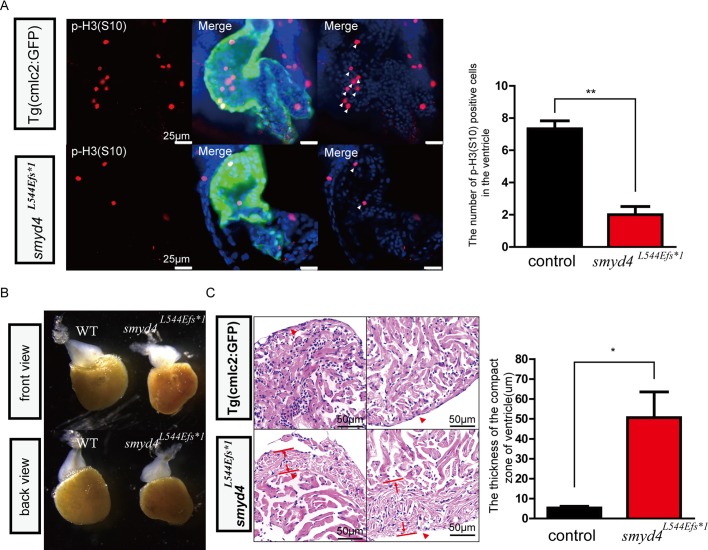
Phenotypical analyses of MZsmyd4L544Efs*1 embryos.(A) The p-H3(S10) immunofluorescence staining showed decreased cell proliferative activity in MZsmyd4L544Efs*1 cardiomyocytes at 48 hpf. The number of p-H3 (S10) positive cells in the MZsmyd4L544Efs*1 ventricles was significantly decreased when compared to the control group (p<0.01, **); (B) The abnormal ventricular morphology of the adult MZsmyd4L544Efs*1 hearts compared to the morphology of control adult hearts; (C) Histological sections and H&E staining images of the adult MZsmyd4L544Efs*1 and control hearts, demonstrating significant thickening of the compact ventricular wall. (The red arrows showed that in the similar compact zone of the ventricle). The quantitative analysis displayed that the thickness of the ventricle compact zone was significantly increased in adult MZsmyd4
L544Efs*1 hearts compared to Tg(cmcl2:GFP) (p<0.05, *).